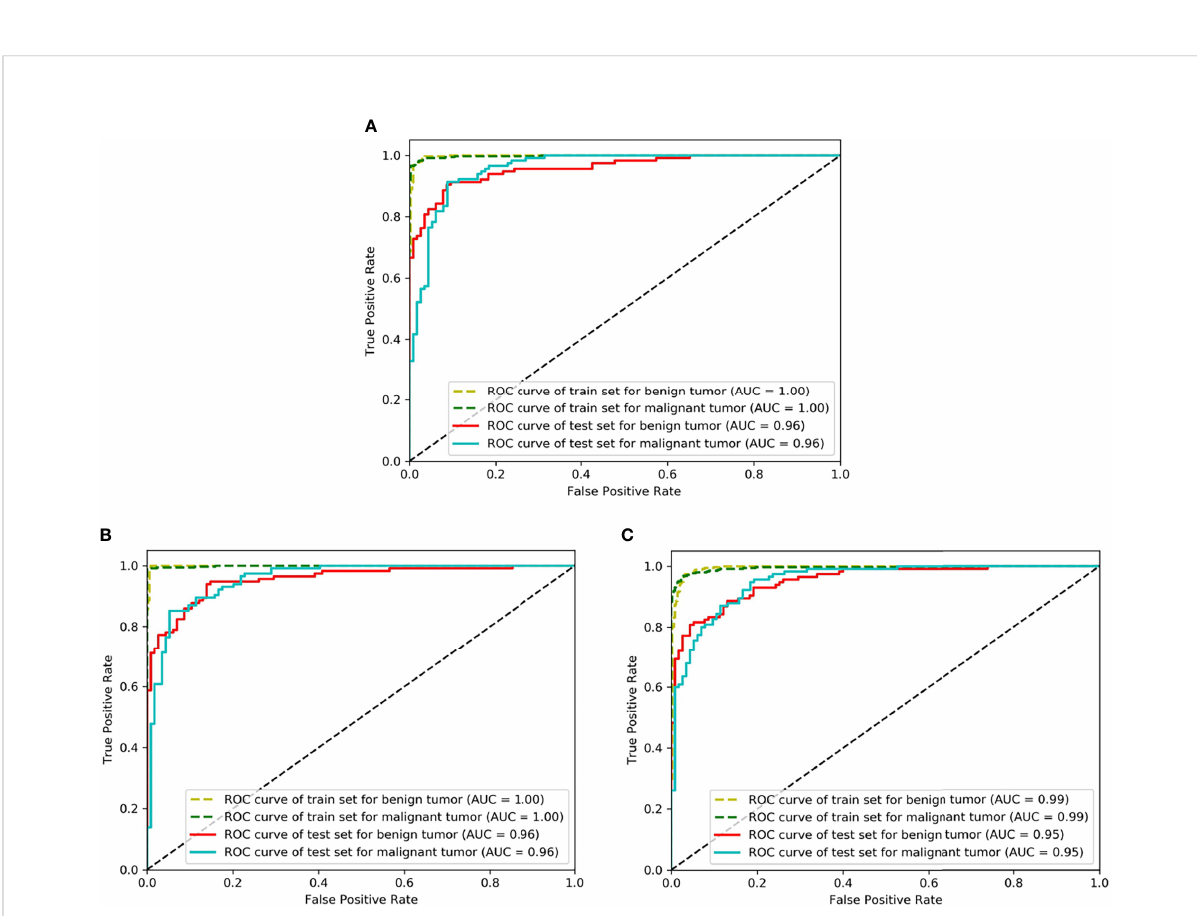
FIGURE 5 The receiver operating characteristic (ROC) curves of Resnet50, VGG16_bn, and DenseNet169. The horizontal axis represents the false positive rate and vertical axis represents the true positive rate. (A) Is the ROC curve of Resnet50 (AUC = 0.96 for malignant tumor), (B) Is the ROC curve of VGG16_bn (AUC = 0.96 for malignant tumor), and (C) Is the ROC curve of DenseNet169 (AUC = 0.95 for malignant tumor).